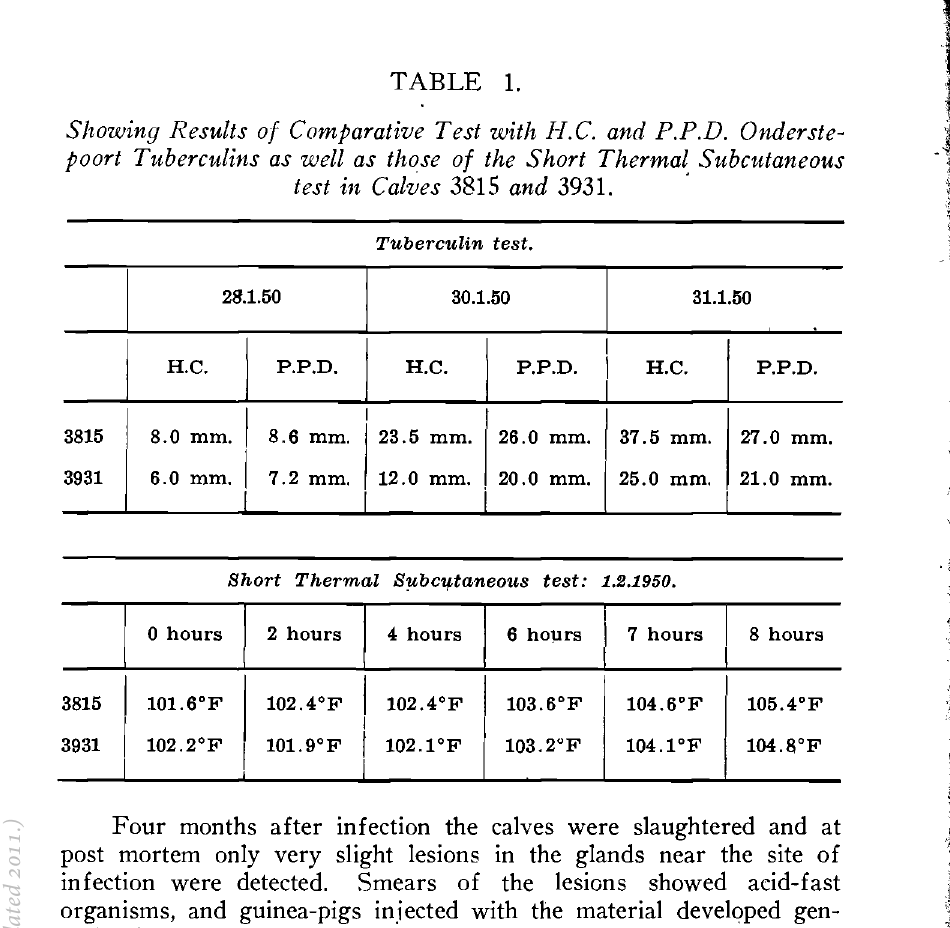
Showing Results of Comparative Test with H.C. and P.P.D. Onderste poort Tuberculins as well as those of the Short Thermal Subcutaneous test in Calves 3815 and 3931.